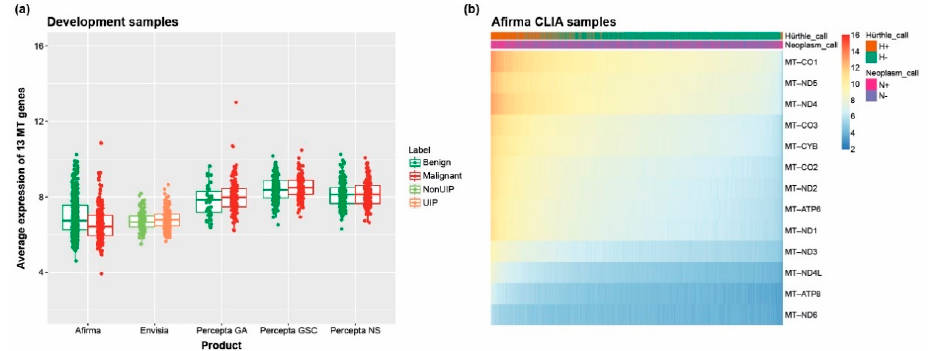
Figure 3. Mitochondrial expression across Unified Assay samples. ( a ) Expression of 13 mitochon- drial genes across thyroid (Afirma), ILD (Envisia), and lung (Percepta) samples; ( b ) expression of mitochondrial genes in the subset of thyroid FNAs. Numbers next to the color bar represent the color scale of normalized gene expression, whereby blue indicates low expression values, yellow indicated intermediately expressed genes, and red represents highly expressed genes. CLIA, Clini- cal Laboratory Improvement Amendments; GA, Genomic Atlas; MT, mitochondrial; UIP, usual in- terstitial pneumonia.